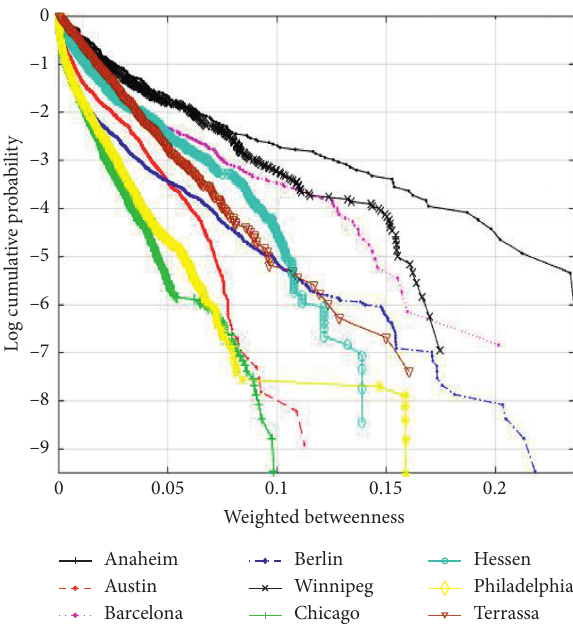
Figure 5: Weighted betweenness centrality of nine